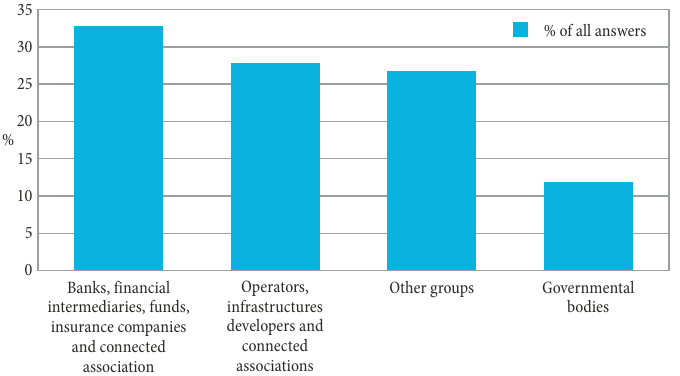
Fig. 3. Profile of the